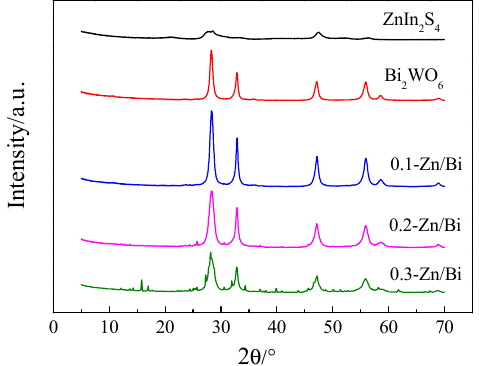
Figure 2. XRD patterns of as-prepared photocatalyst.